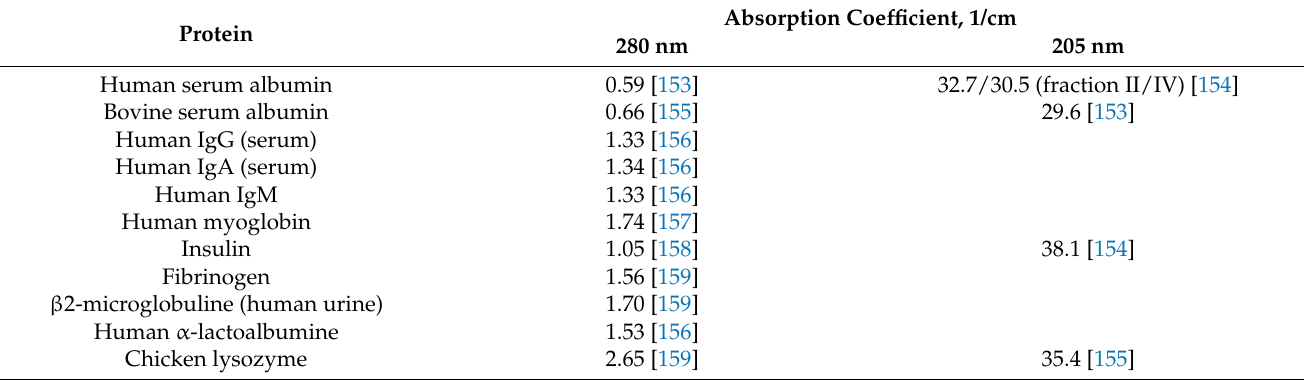
Table 1. Protein absorption coefficients in the UV region in 1 g/L water